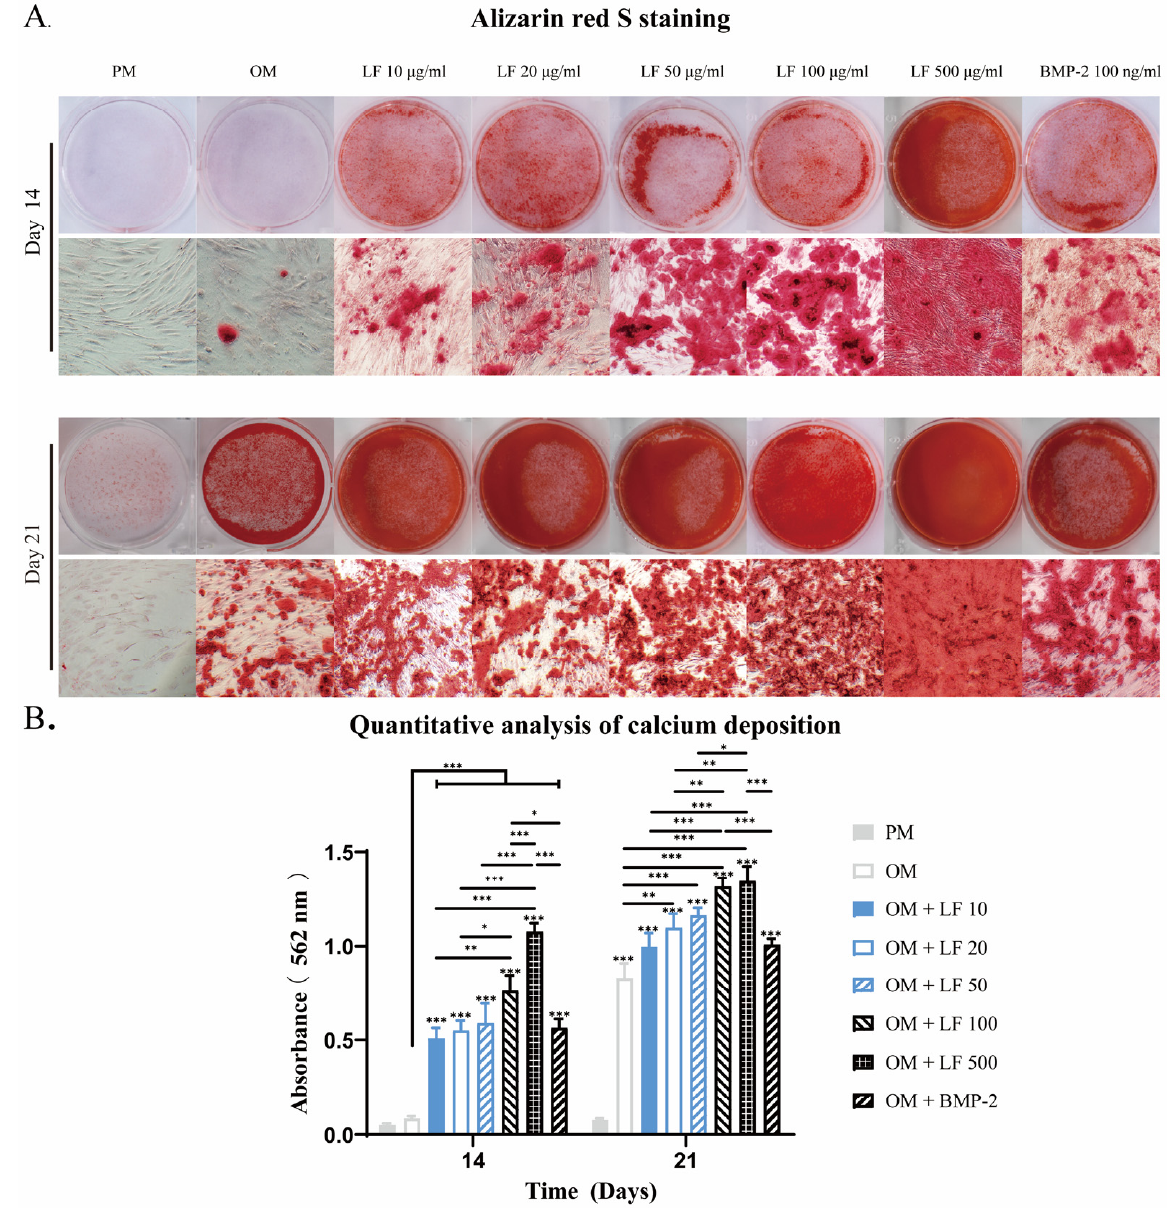
Figure 4. After 14 and 21 days of incubation, an analysis of calcium deposition in LF and BMP-2 treated ADSCs was conducted. ( A ) Alizarin red stains micrographs. ( B ). Semi-quantification of Alizarin red staining. Calcium was not detected in the PM group. LF and BMP-2 increased calcium deposits, and most calcium depositions were observed in ADSCs treated with LF at 100 and 500 µ g/mL. On the top of a column without a capped line, seven OM groups’ significance levels are compared with those of PM group (* p < 0.05, ** p < 0.01, and *** p < 0.001).